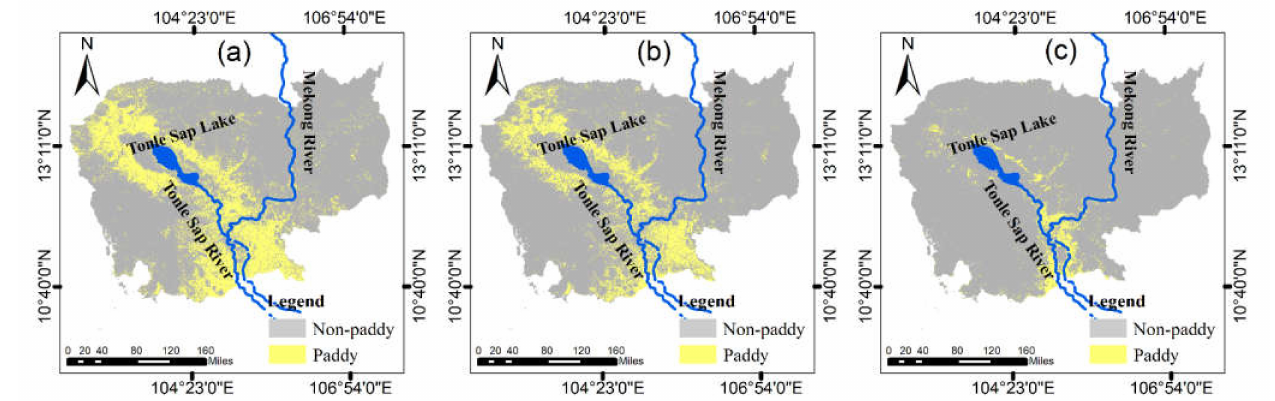
Figure 11. Spatial distribution of the paddy products in the study area. ( a ) Results obtained in this study, ( b ) SERVIR MEKONG, and ( c )